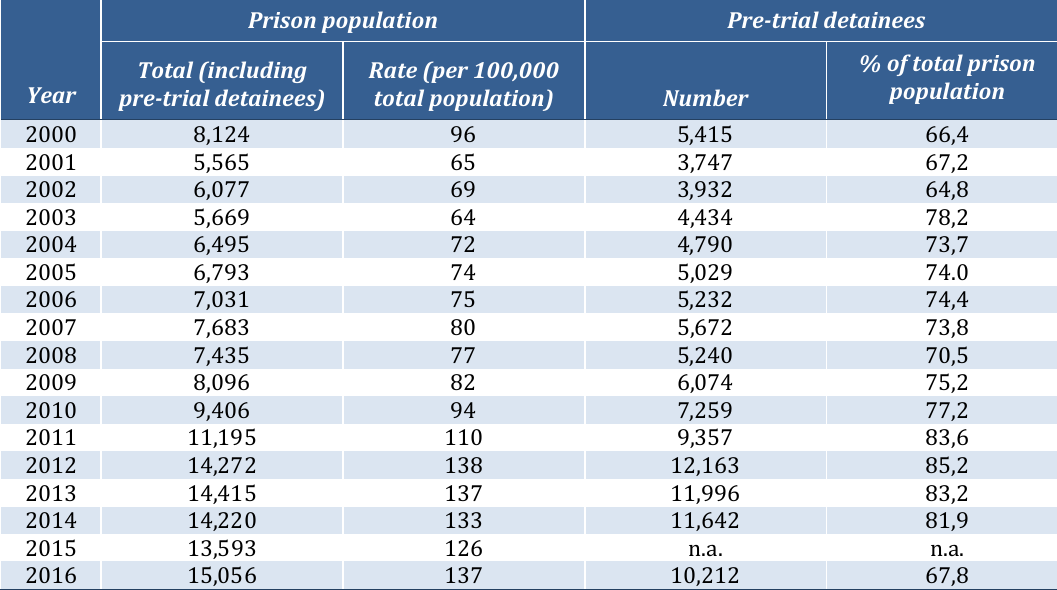
Figure 1: Prison population trend (per 100,000 of national population) Table 3: Prison population